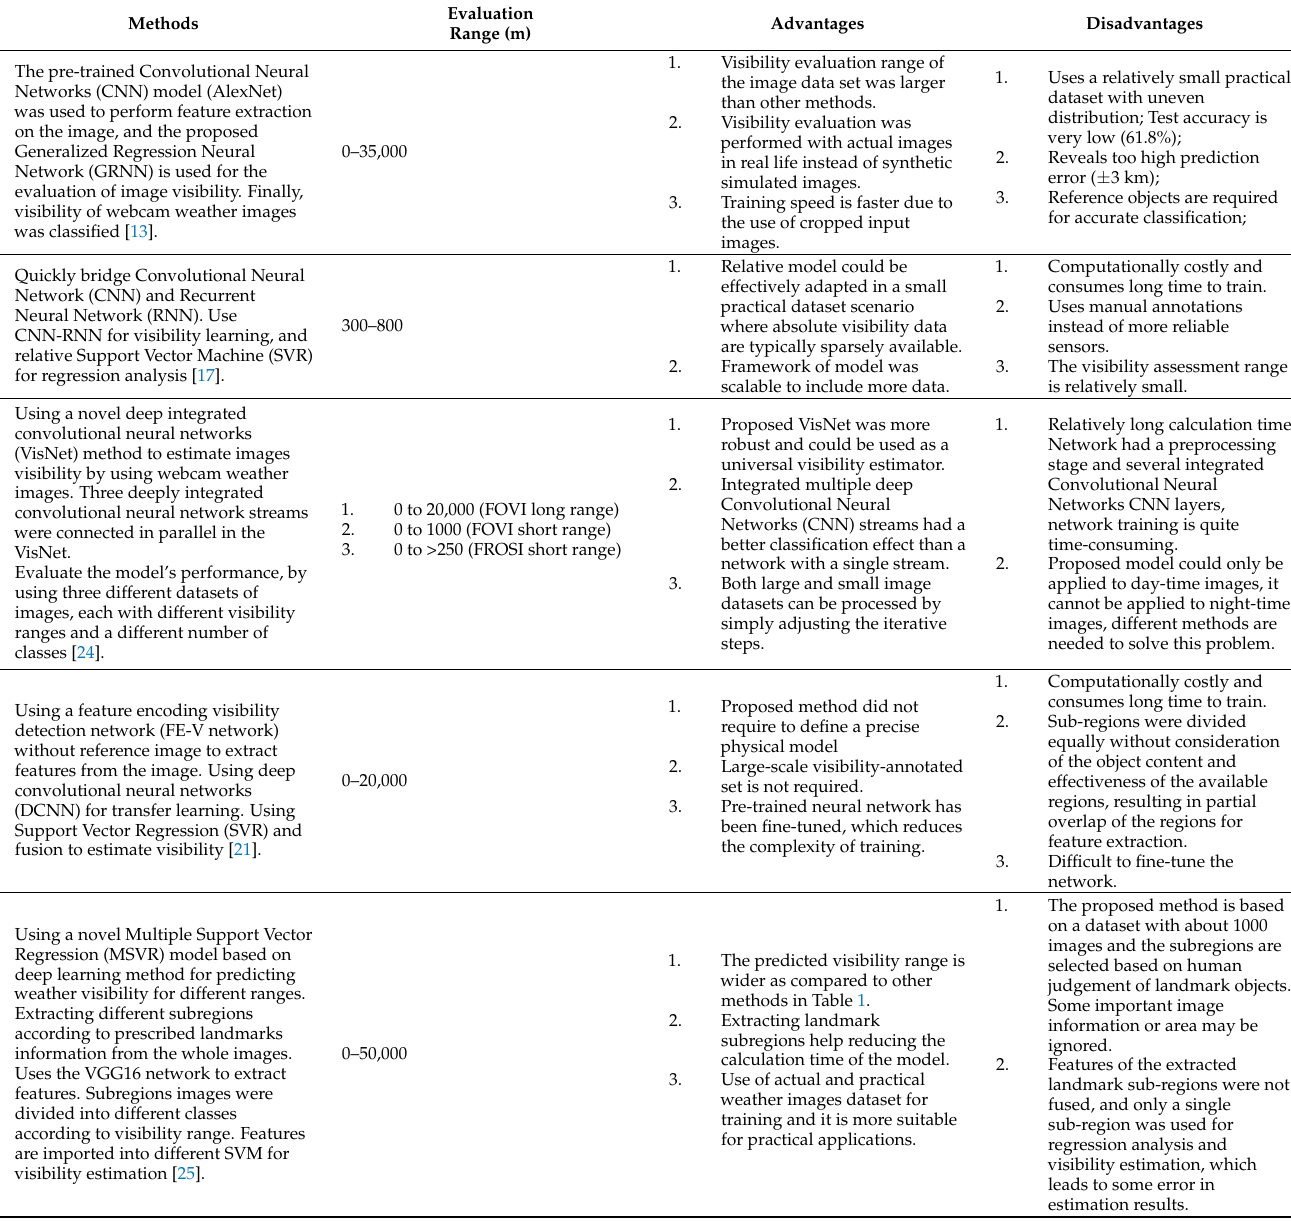
Table 1. Comparisons of some proposed